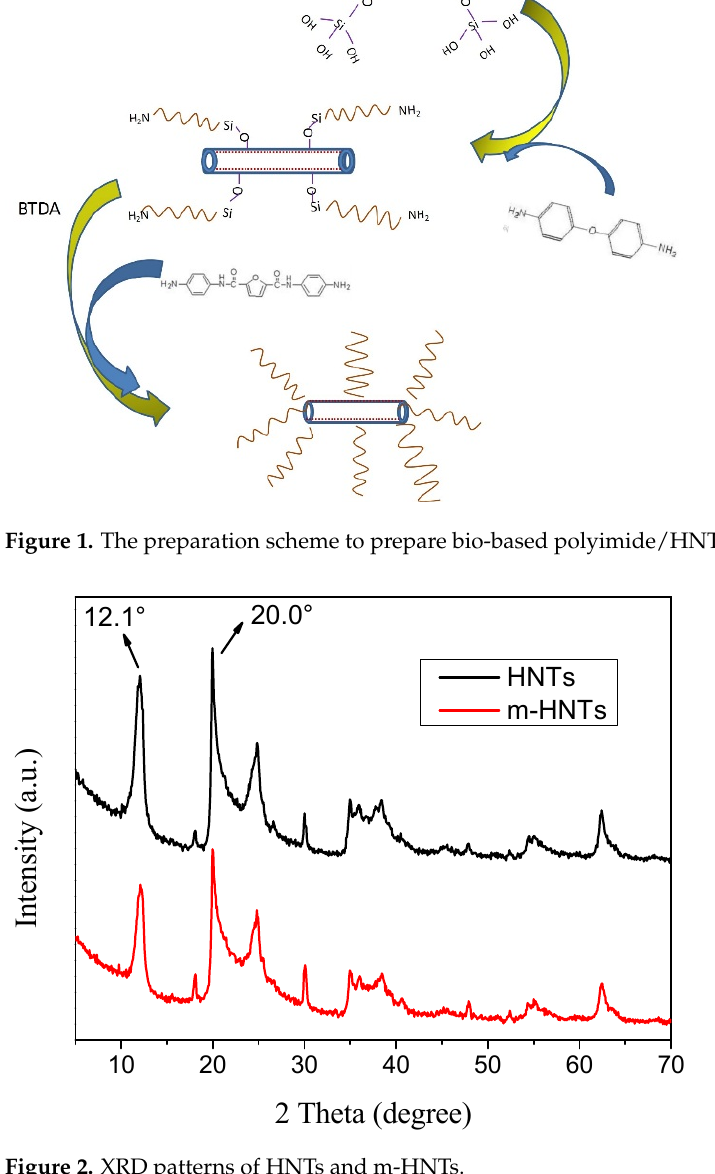
Figure 2. XRD patterns of HNTs and m-HNTs.